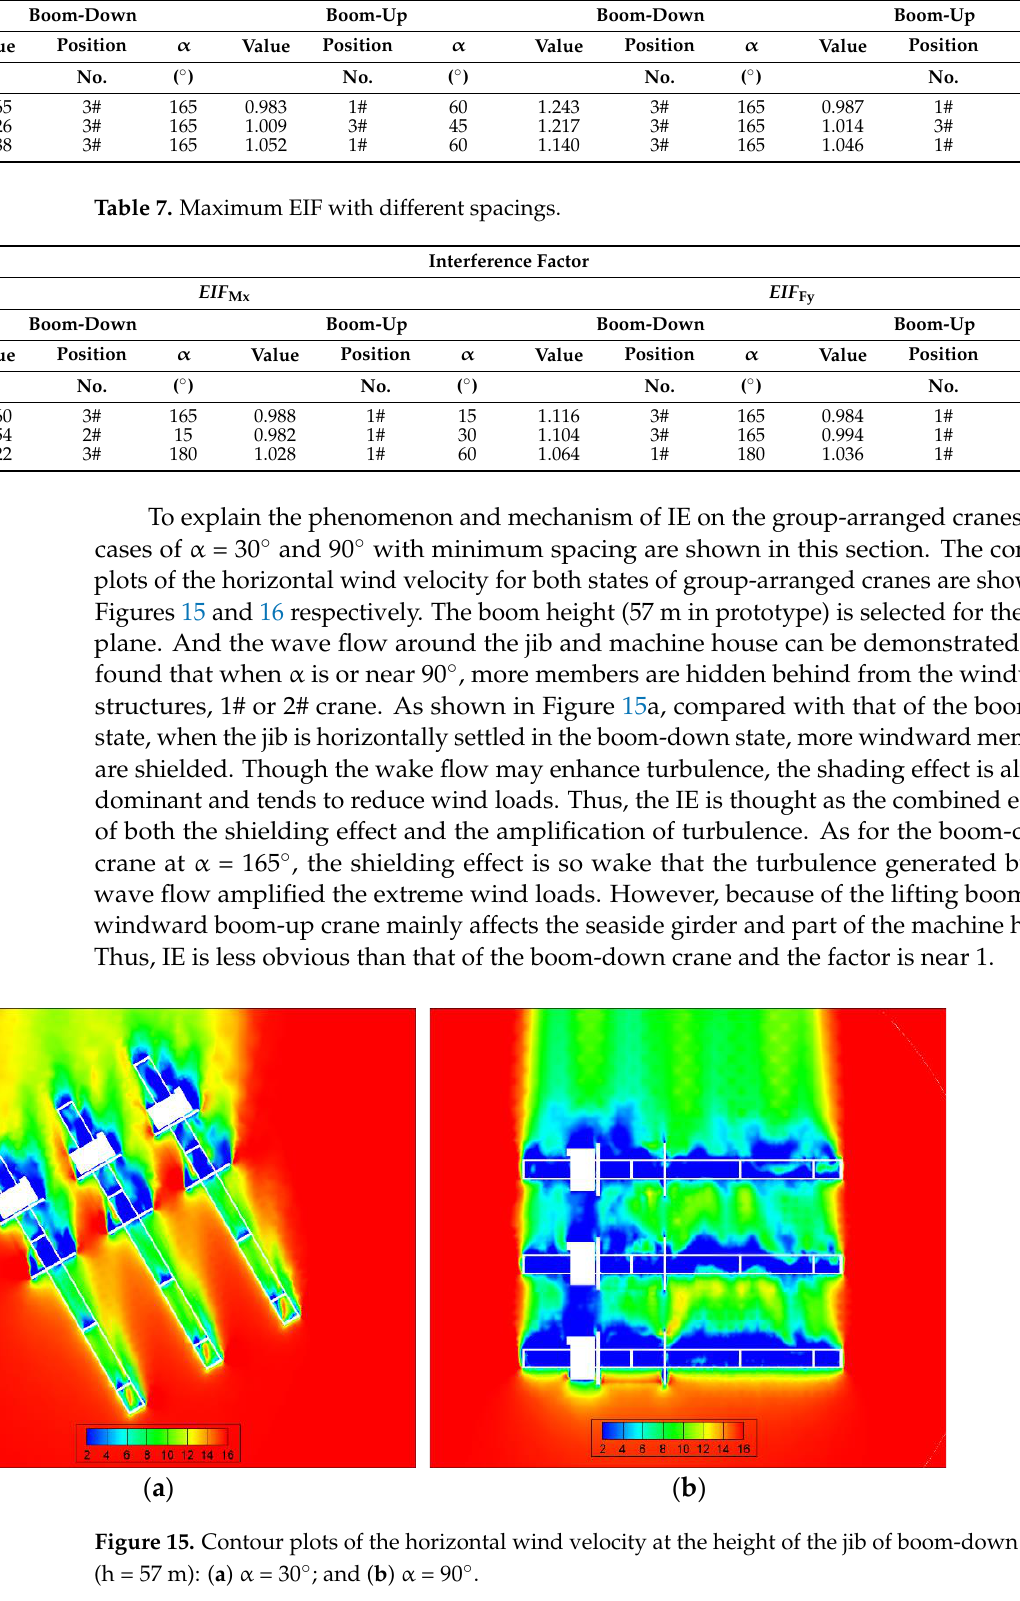
( b ) Figure 16. Contour plots of the horizontal wind velocity at the height of the jib of the boom-up crane (h = 57m): ( a ) α = 30°; and ( b ) α = 90°. 4.2. Interference Effects of Wind-Induced Response The prototype finite element model was established using the ANSYS 17.0 software platform. Yield stress for the two main types of steel, Q345, and Q235, were 310 and 215 MPa, respectively. Q235 is mainly used in auxiliary materials, whereas Q345 is widely used in the main material. Beam 188 and Mass 21 elements were, respectively, used to simulate the members and the mass of the auxiliary facilities, such as machine houses and lifts. By using the subspace method in the modal analysis, the first three natural frequen- cies and the vibration modal characteristics were obtained, as shown in Table 8. The first two modal shapes are shown in Figure 17. Table 8. The first five natural frequencies of the quayside container crane models. No.